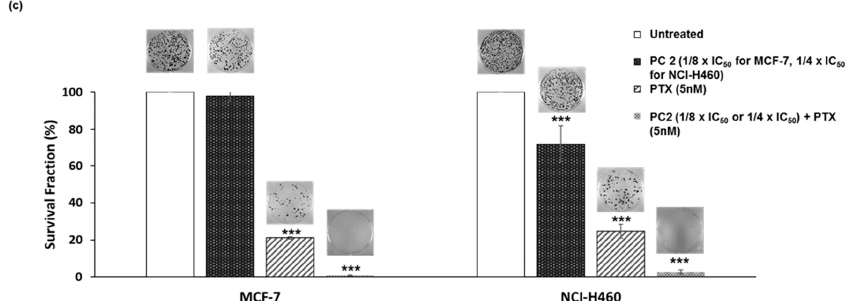
Figure 6. The chalcone PC2 enhances cytotoxicity of cancer cells to paclitaxel (PTX). ( a ) Relative cell viability of MCF-7 and NCI-H460 cells treated with increased concentrations of PTX (0–50 nM) for 48 h; ( b ) Relative cell viability of MCF-7 and NCI-H460 cells treated with PC2 (1/3 × IC 50 ) in combination with PTX (5 or 10 nM) for 48 h; ( c ) Colony forming efficiency of MCF-7 and NCI-H460 cells: cells were exposed for 48 h to PC2, PTX, or the combination of both, washed, and allowed to grow in fresh medium for 10 days before crystal violet staining. Representative figures are shown and viable colonies, of at least 50 cells each, (top) were counted and the results expressed as % survival fraction relative to control (bottom). Results are expressed as mean ± standard deviation (SD), from at least three independent experiments. (***) represents p < 0.001; (**) represents p < 0.01, PC2 and/or PTX versus control.